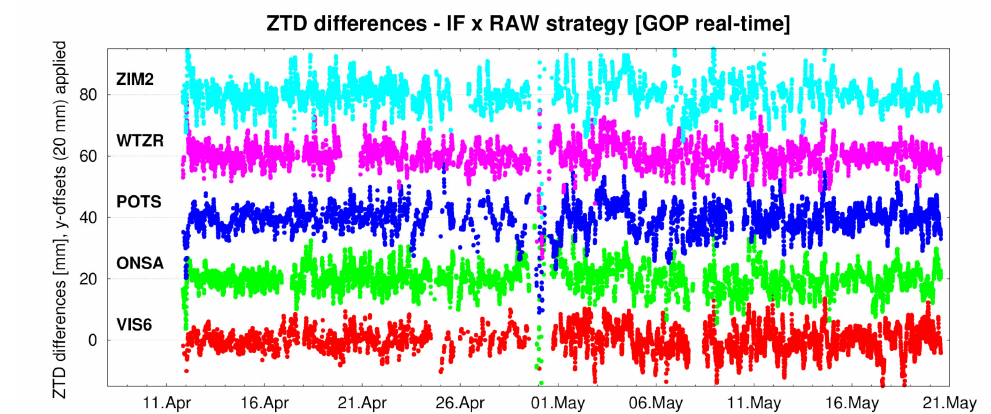
Figure 6. Time series of the di ff erence between ZTDs, as obtained with ionosphere-free (IF) and raw (RAW)